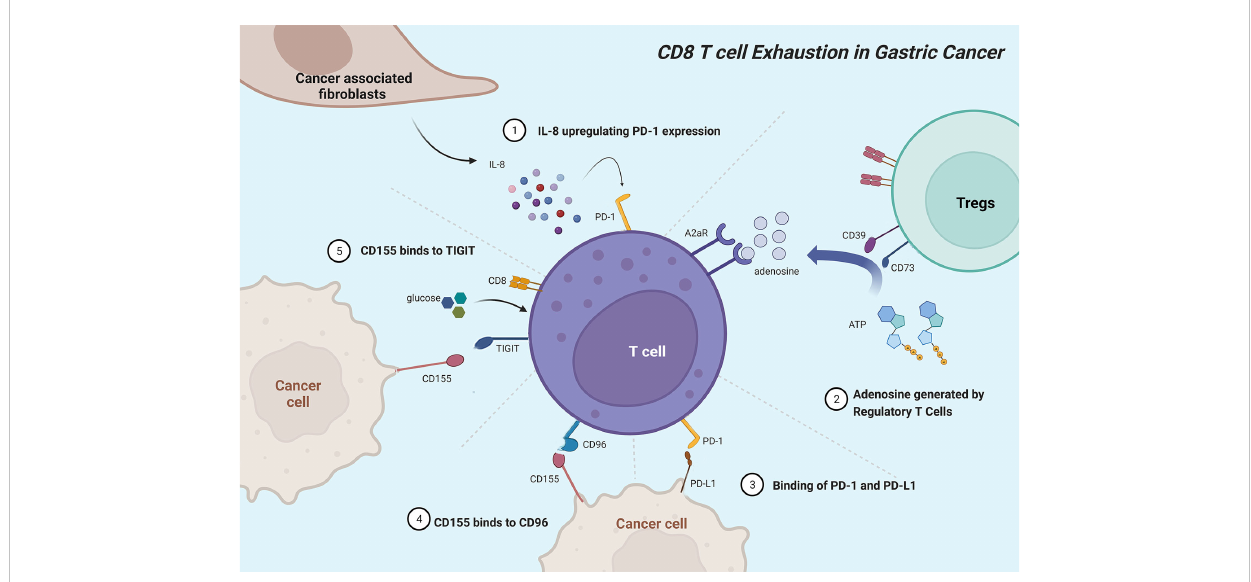
FIGURE 3 Mainly mechanisms of CD8 + T cell exhaustion in gastric cancer. Cancer-associated fi broblasts originate IL-8 to upregulate PD-1 expression in CD8 + T cells. Ectonucleotidases CD39 and CD73 catalyze adenosine that interactives with A2aR to inhibit CD8 + T cells. PD-L1 on tumor cells interacts with PD-1 to induce T-cell exhaustion. CD96 mainly binds to CD155 and associates with CD8 + T cell exhaustion phenotype. Gastric cancer cells expressing CD155 deprive CD8 + T cells of glucose and impair CD8 + T cell effector functions, which can be rescued by additional